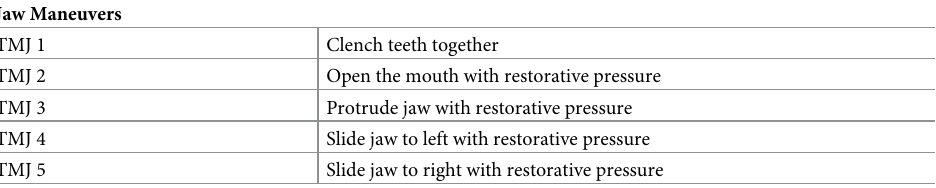
Table 1. Maneuvers used for somatic testing in our